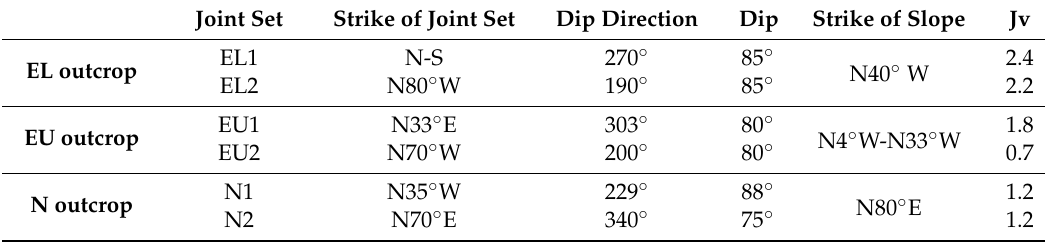
Figure 8. Final stereo-plot derived from the analysis of the TLS point cloud and geomechanical scanline for EL ( a ), EU (Upper East) ( b ), and N (North) ( c ) outcrop. Table 3. Data of joint sets in the investigated outcrops. Jv represents the standard joint index